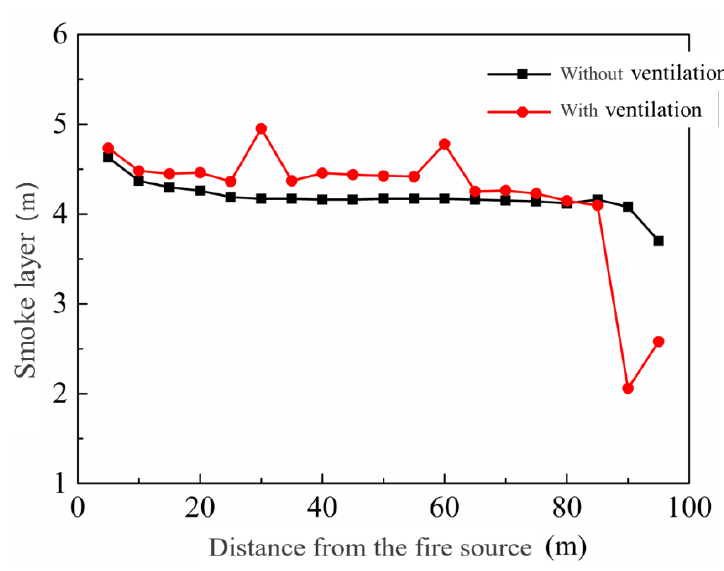
Figure 20. Height of smoke layer in tunnel (semitransverse